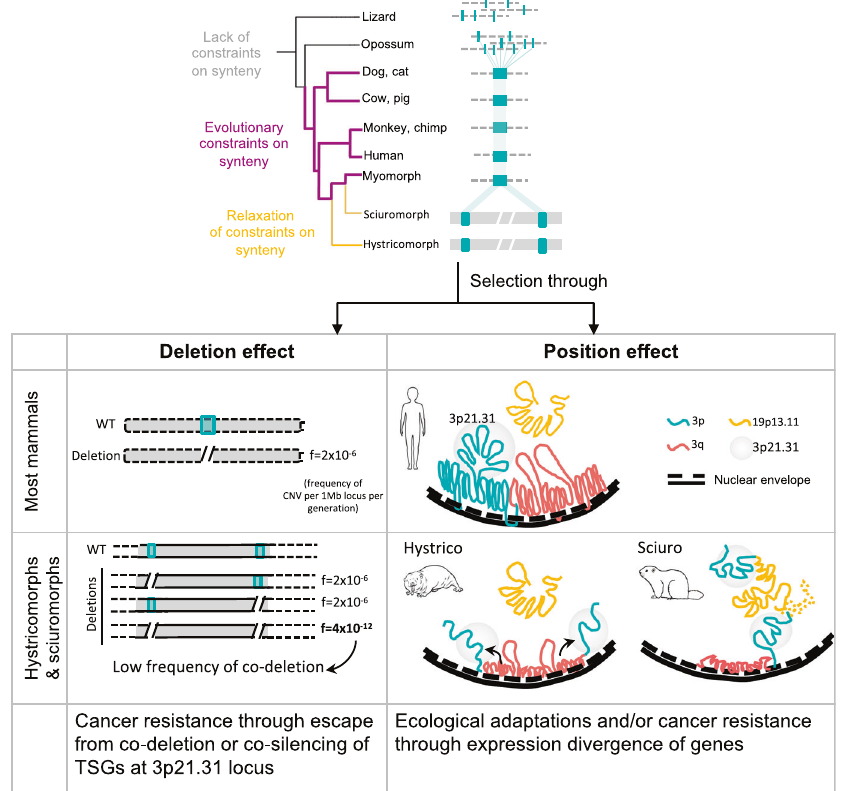
Fig. 8 The proposed model for the evolution of cancer resistance in hystrico- and sciuromorphs. The frequency of CNVs per Mb per generation was obtained from Itsara et al. 133